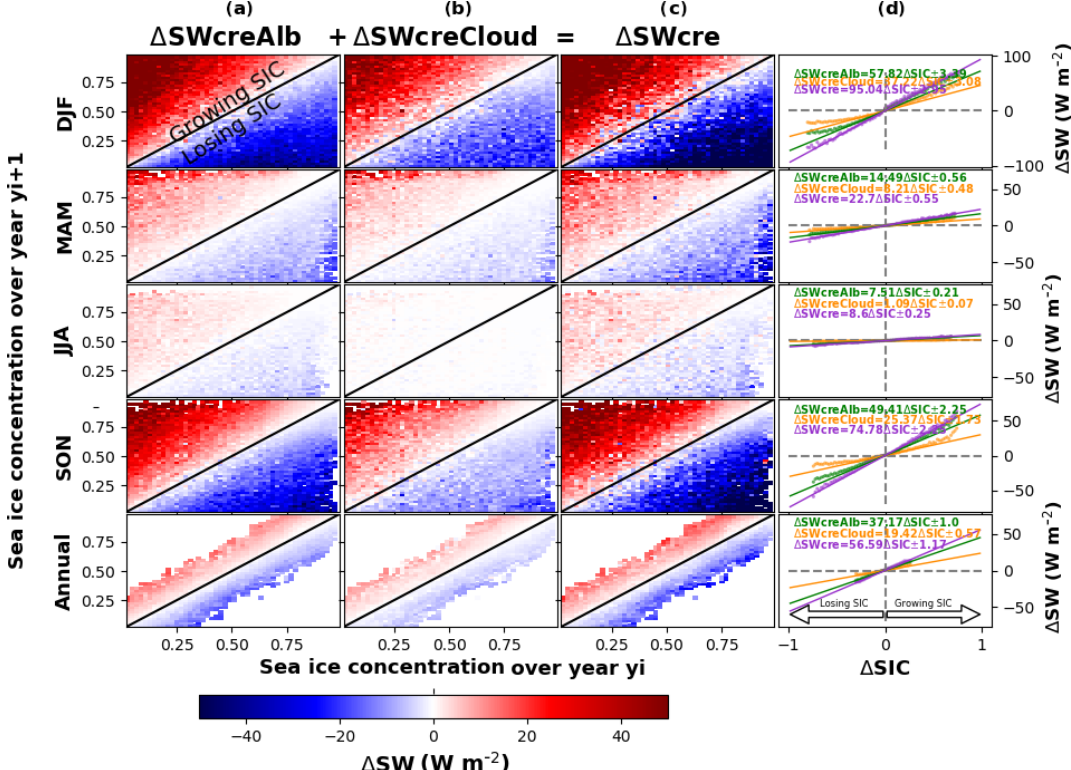
Figure 7. Seasonal and annual changes in SW cre Alb, SW cre Cloud and SW cre over the Antarctic polar sea region as a function of SIC change between 2 consecutive years, y i + 1 and y i , from the 2001 to 2016 time period. The analysis is based on the method described in Sect. 2.7 and observations from satellites